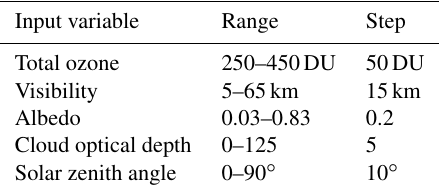
Table 3. The range of the inputs and steps of the lookup